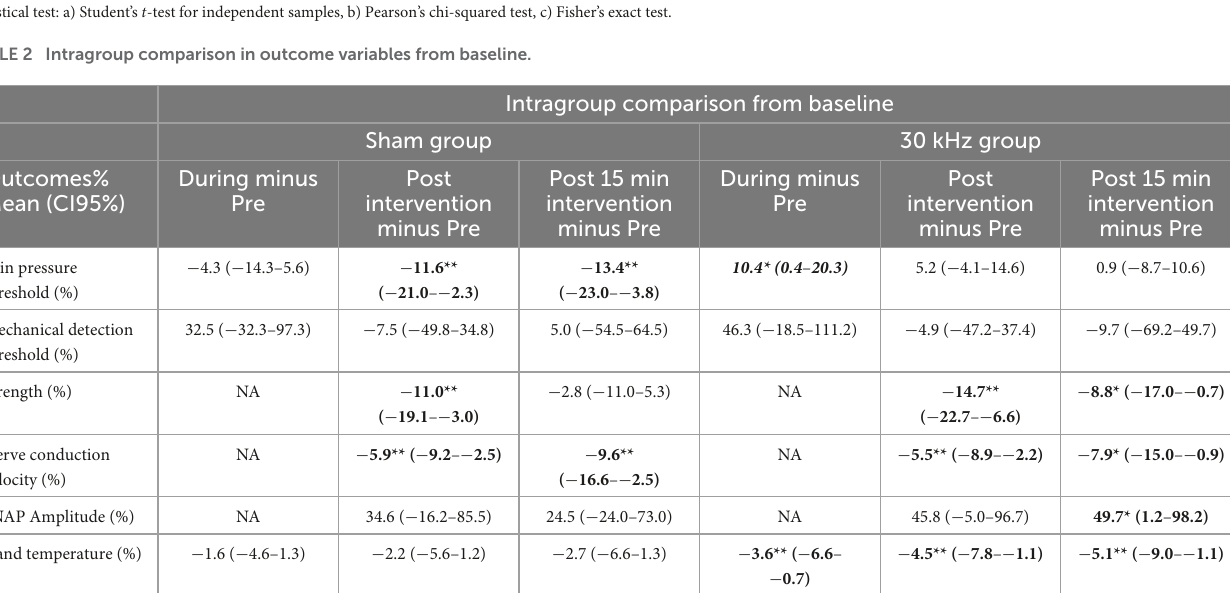
TABLE 2 Intragroup comparison in outcome variables from baseline.